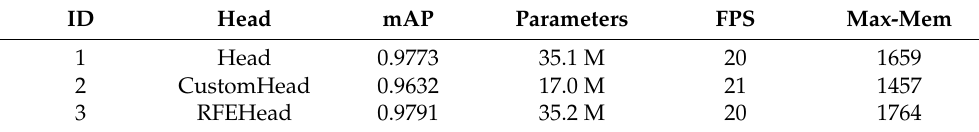
Table 4. Comparison of different detection